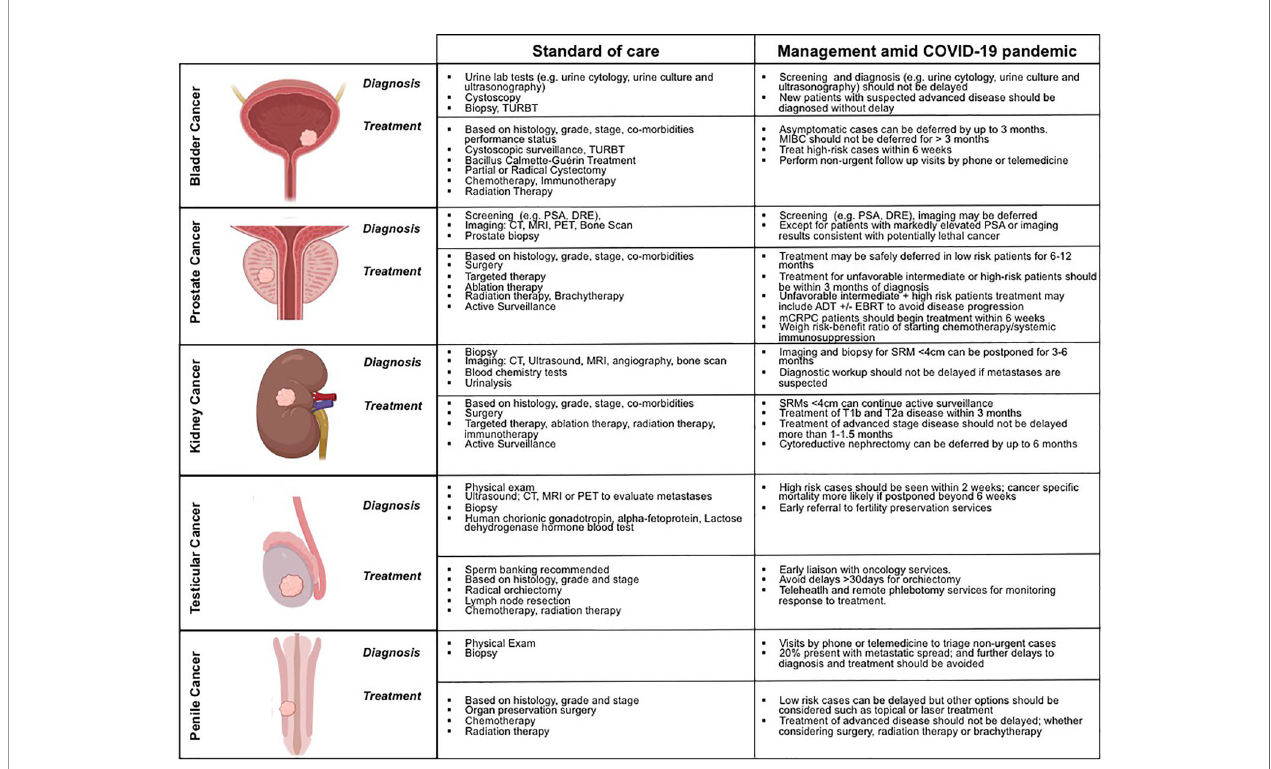
FIGURE 2 | Contrasting the clinical diagnosis, management, and treatment of patientswith prostate, bladder, kidney, testicular, and penile cancers, before and during the COVID-19